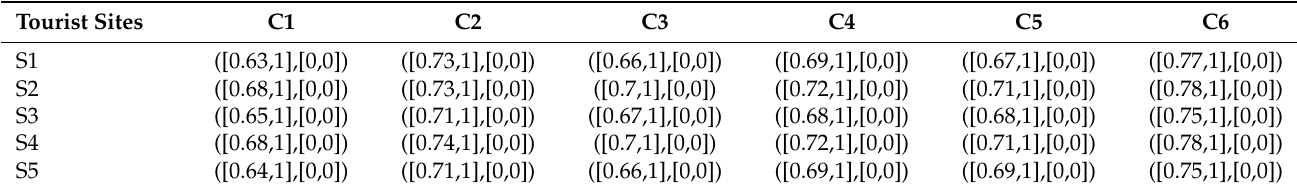
Table 5. Aggregate IVIF dataset for the evaluation of tourist